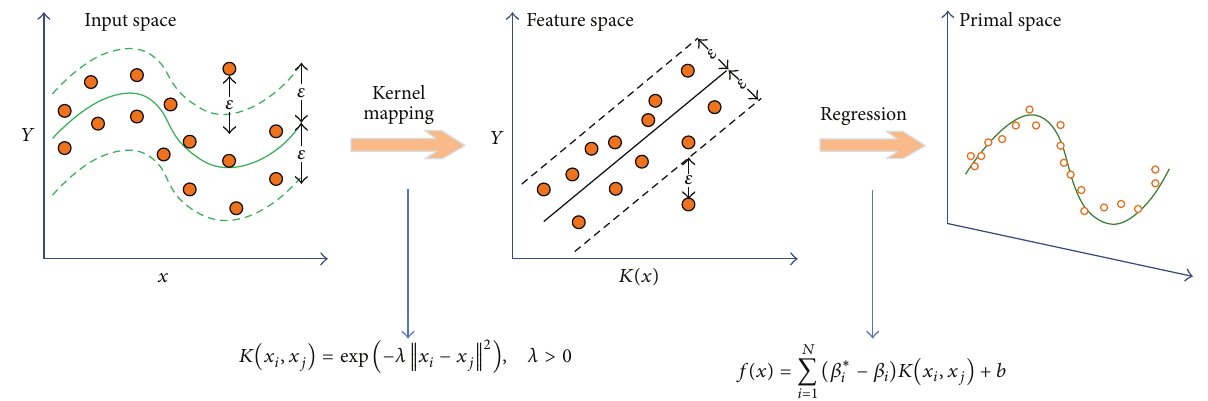
Figure 2: A schematic diagram of SVR architecture.